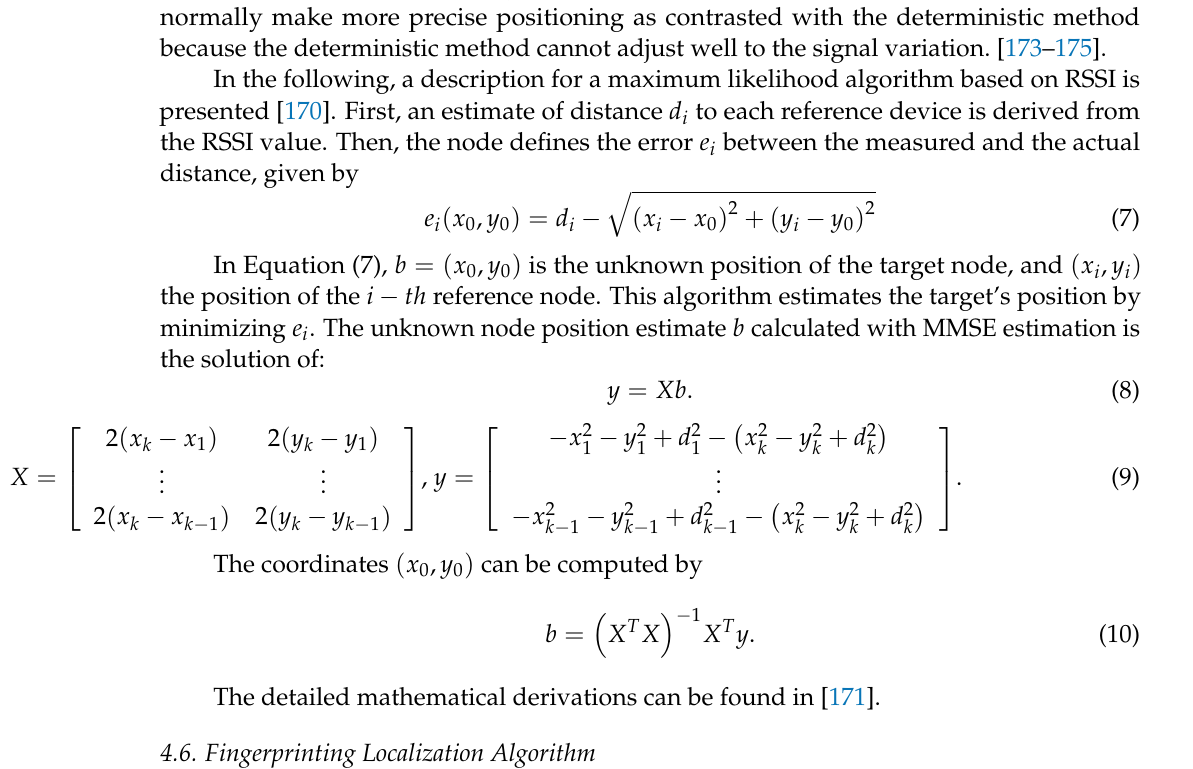
Figure 11. Maximum likelihood ‐ based positioning method.